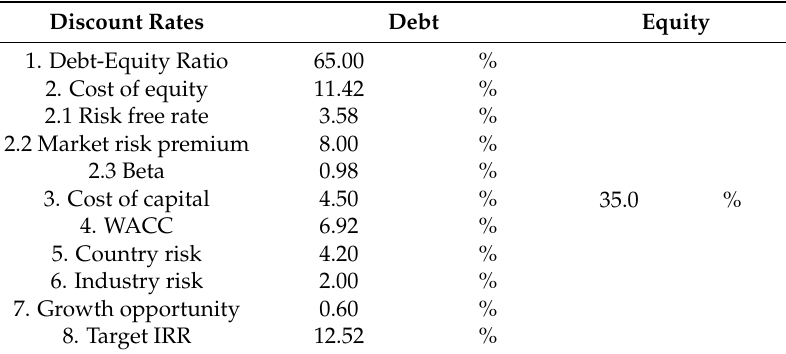
Table 9. Target internal rate of return